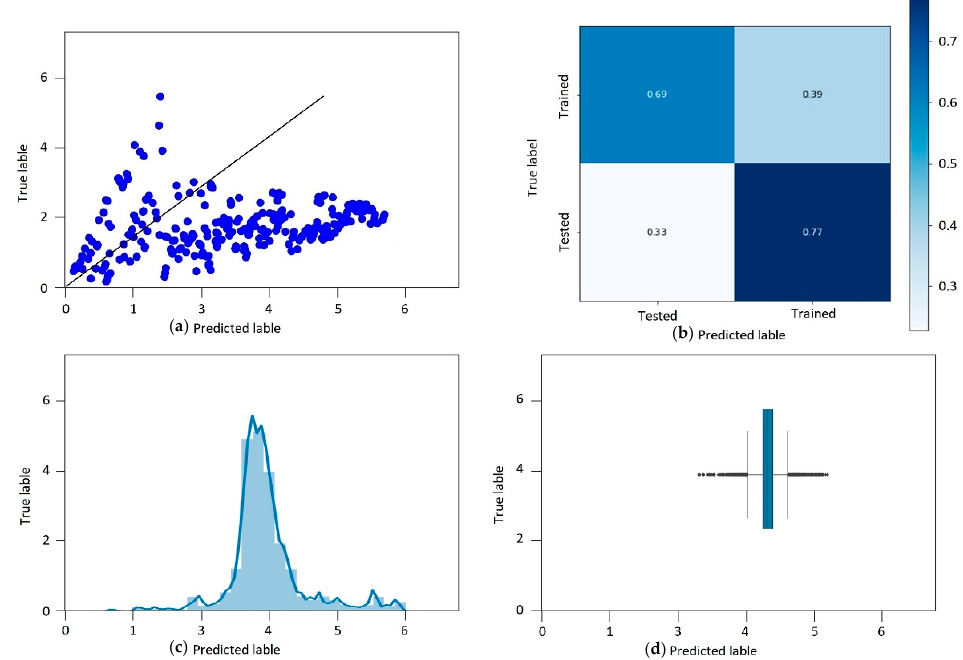
Figure 11. Statistical specifications of the SVM model’s results: ( a ) Pearson’s correlation coefficient, ( b ) heat map, ( c ) frequency distribution, and ( d ) boxplot diagram.